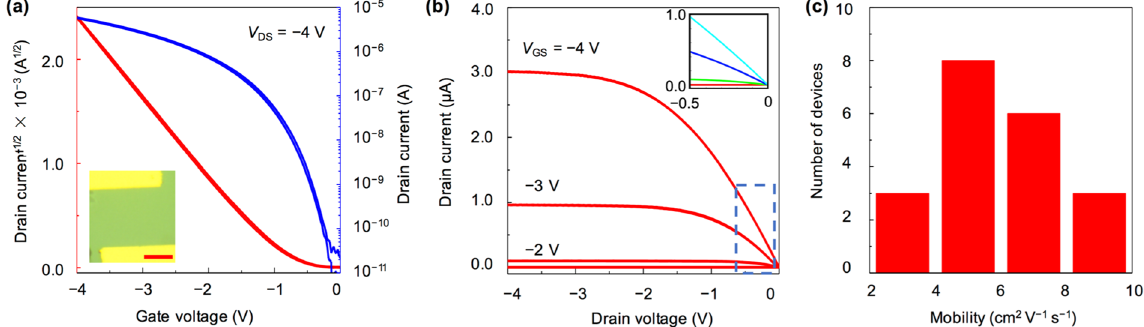
Figure 3. ( a ) Transfer characteristics at a drain voltage of − 4 V. The inset shows the optical microscope image of the measured device. Scale bar, 20 μ m. ( b ) Output characteristics at different gate voltages. Inset shows